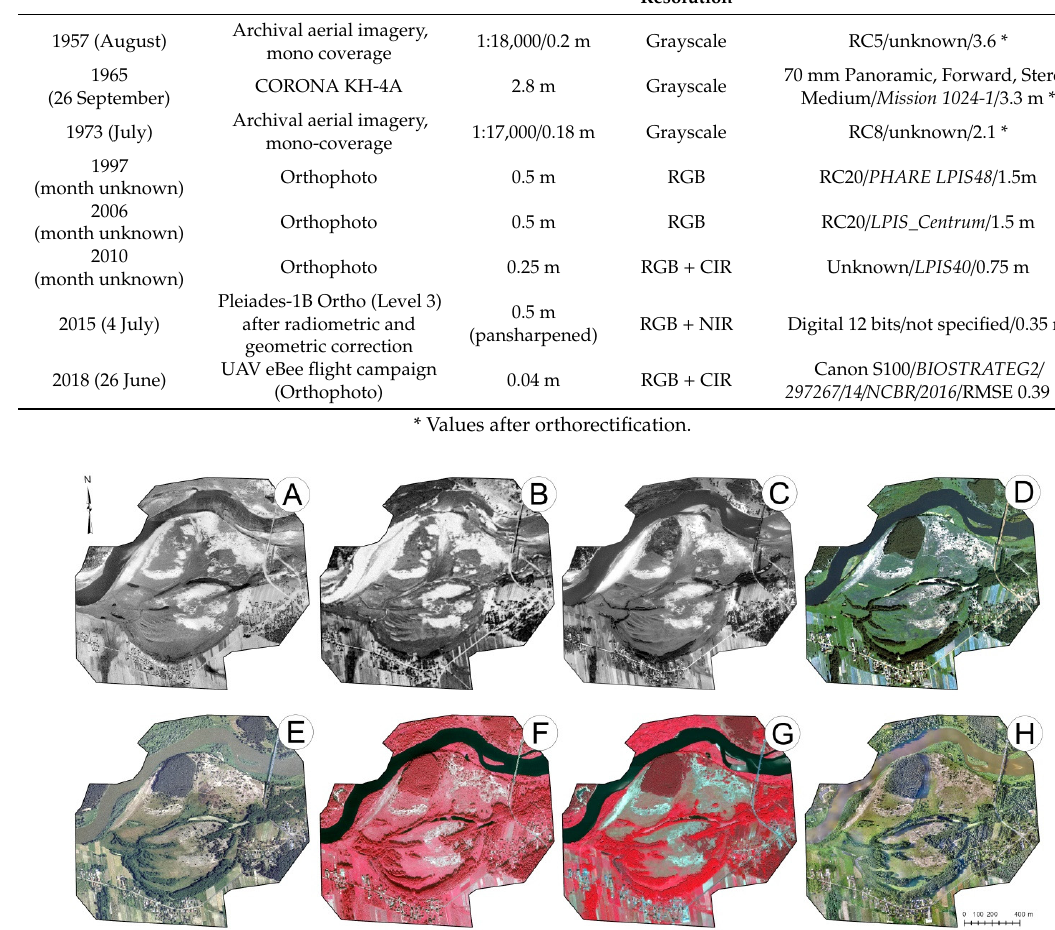
Figure 3. Imagery used for geographic object-based image analysis (GEOBIA) covering the case study location: ( A ) 1957, ( B ) 1965, ( C ) 1973, ( D ) 1997, ( E ) 2006, ( F ) 2010, ( G ) 2015, and ( H )